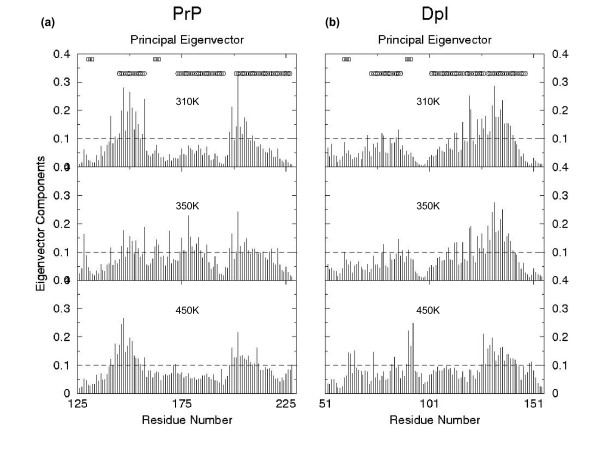
Principal Eigenvector Components. The components of the eigenvectors associated with the largest eigenvalue from the energy decomposition analysis in the all-atom MD simulations for (a; left panel) the PrP protein and (b; right panel) the Dpl protein at different temperatures, reported in each single panel. The broken horizontal line depicts the threshold value as calculated in equation (3) in Methods. In the top panels, the secondary structural elements are reported in correspondence to residue numbers: circles represent α-helical and squares represent β-sheet structures.